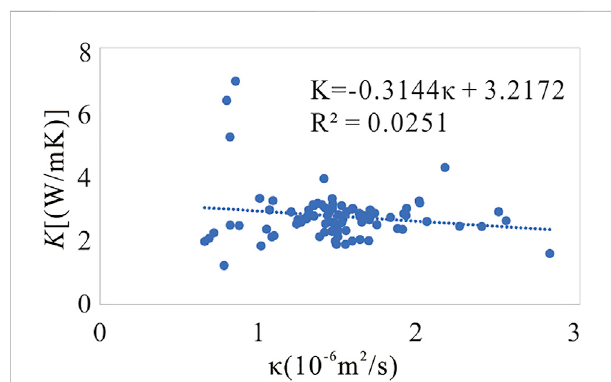
FIGURE 11 Superposition diagram of the geothermal geological map with radioactive heat generation rate